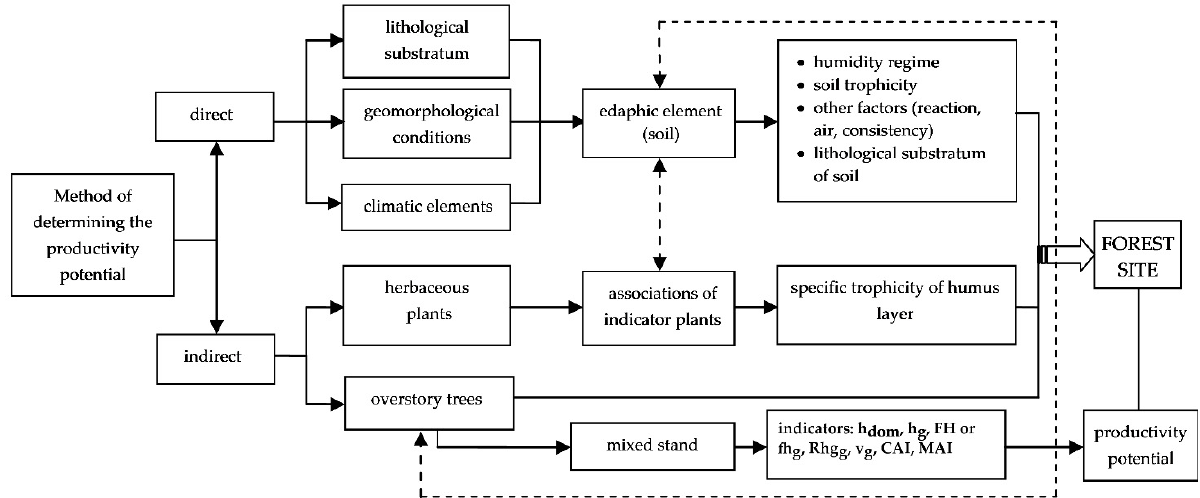
Figure 2. Research method. The method was applied at the level of a 507.07 ha key area. For the soil study, samples were taken from soil profiles to determine the physicochemical properties. At the key area, the sites were identified based on soil characteristics, herbaceous plants, and stand layer. Each stand was studied as a whole. Several relevant biophysical parameters, with roles in each stand structure description, were determined. The models developed at the level of the key area differentiated three representative sites for mixed beech-coniferous stands and correctly estimated their productivity, so that the application of the models was extended to the level of the study area of 9107.79 ha. For similar sites in the study area, the models generated at the key-area level estimated the same level of